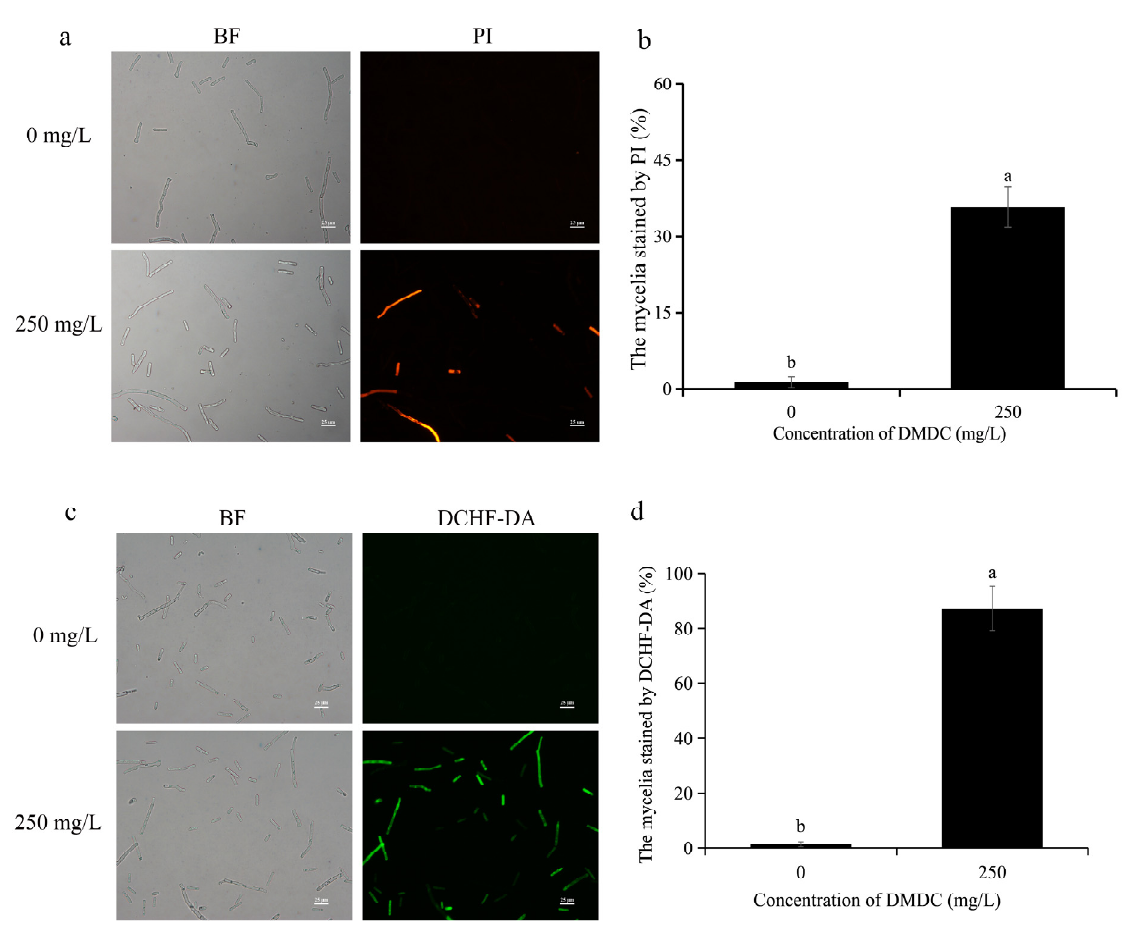
Figure 5. Effects of DMDC treatment on cell membrane integrity and ROS accumulation of G. citri- aurantii . G. citri-aurantii stained by PI ( a ) and DCHF-DA ( c ). Bars = 25 μ m; fluorescence signals were detected in 35.78% of mycelia after treatment with 250 mg/L DMDC ( b ). A large number of fluorescence signals were detected after DMDC treatment ( d ). Different letters on each column of ( b , d ) represent significant differences ( p < 0.05) according to a t-test.